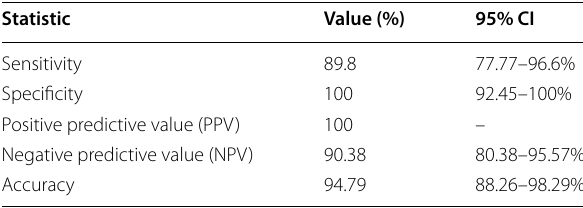
Table 9 Diagnostic value of DWI in evaluation of papilledema